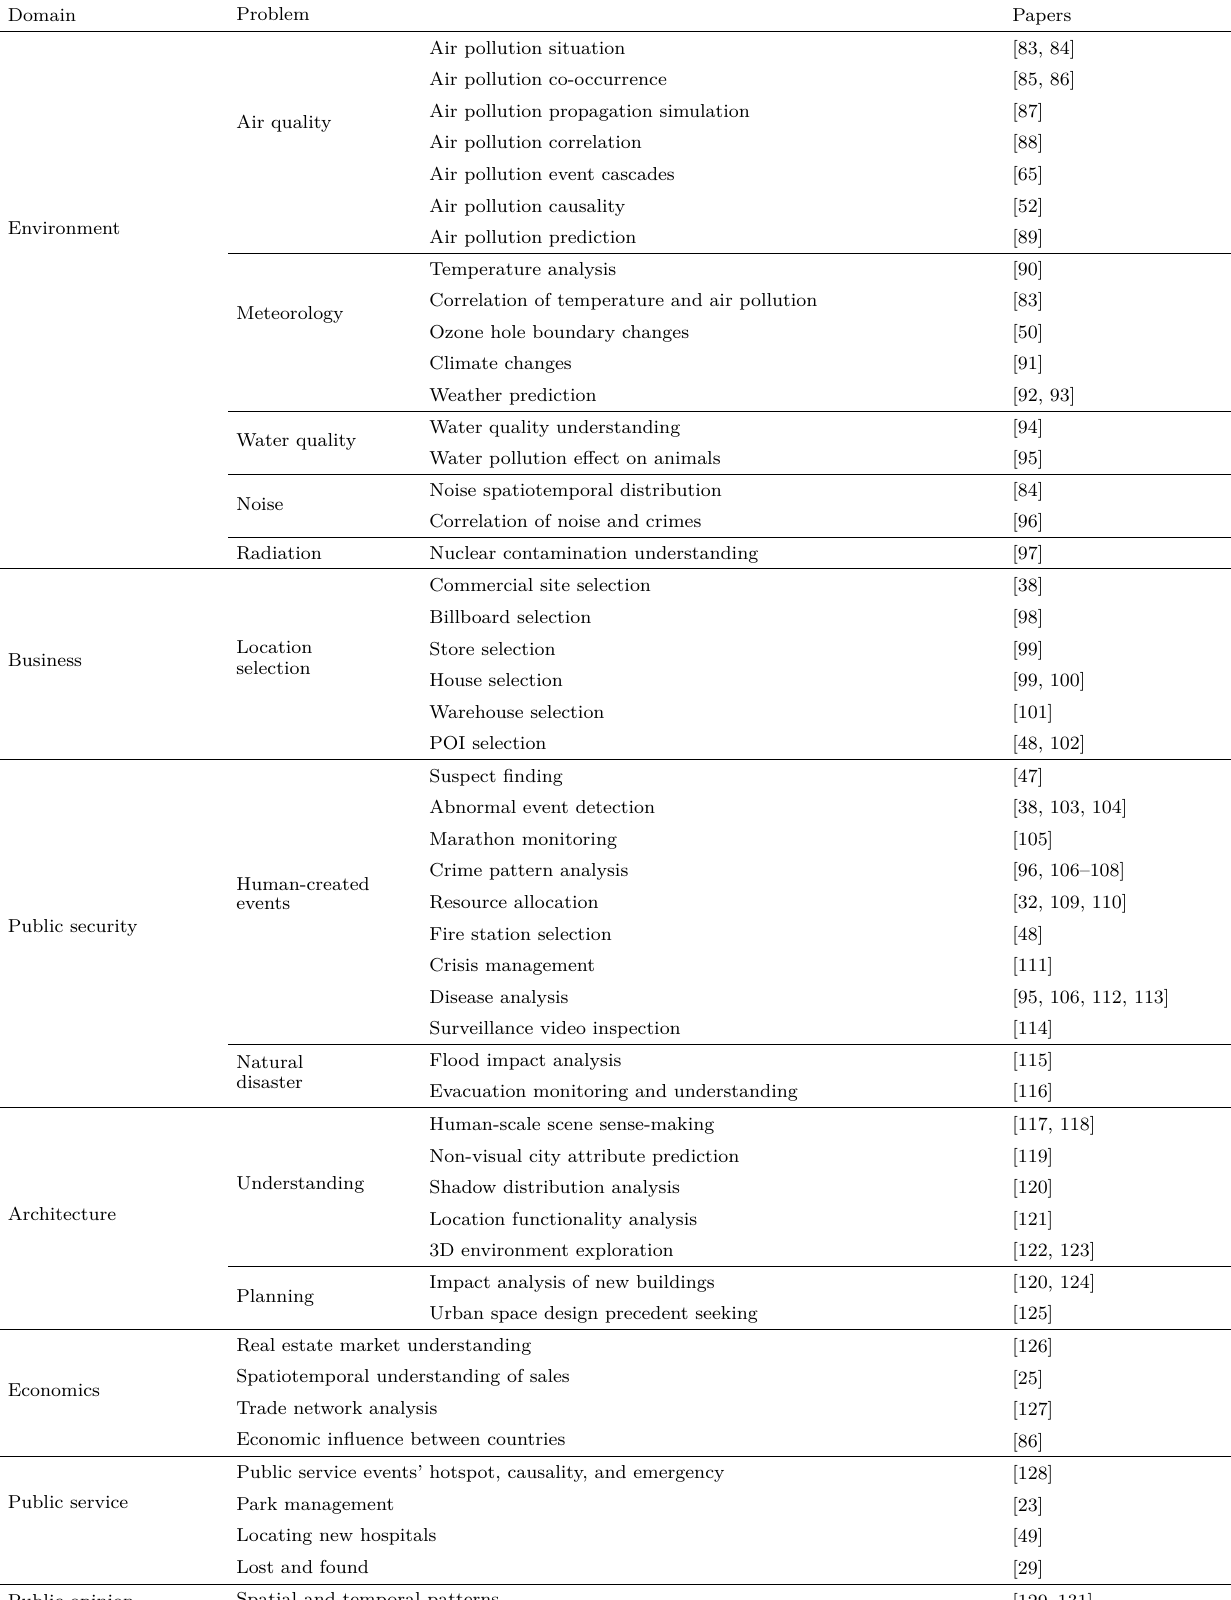
Table 2 Domain problems studied by existing urban visual analytics approaches (continued from Table